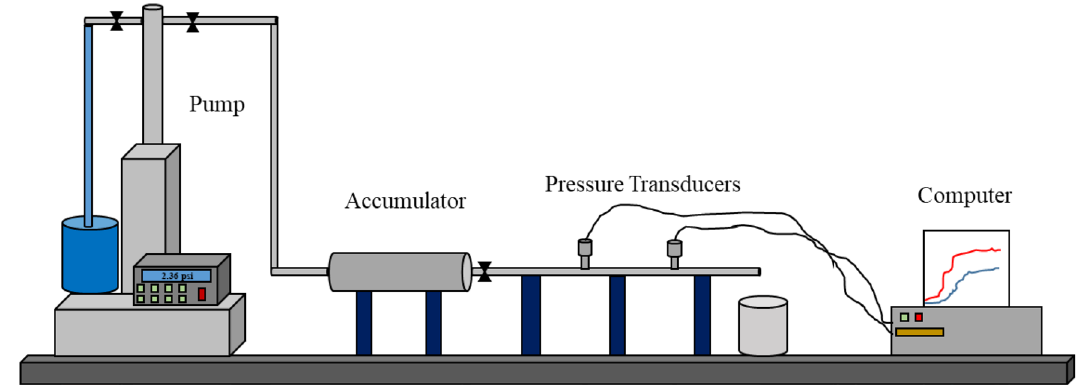
Fig. 1 Experimental setup